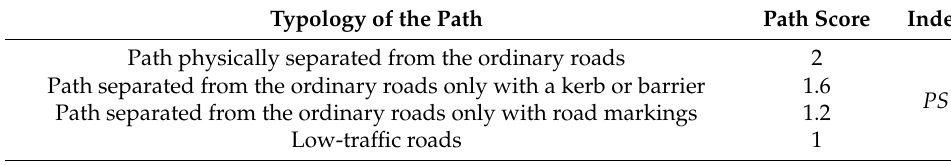
Table 4. Scores and indexes used for the assessment phase. Typology of the Path Path Score